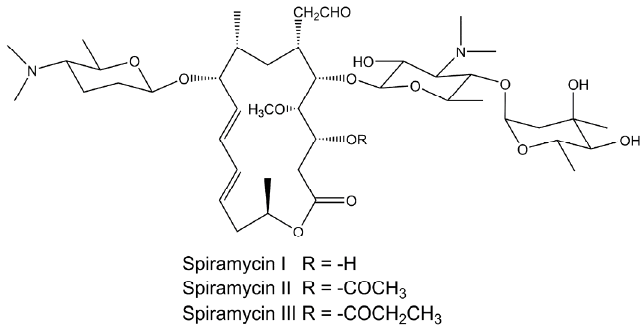
Figure 1. Molecular structure of spiramycins.